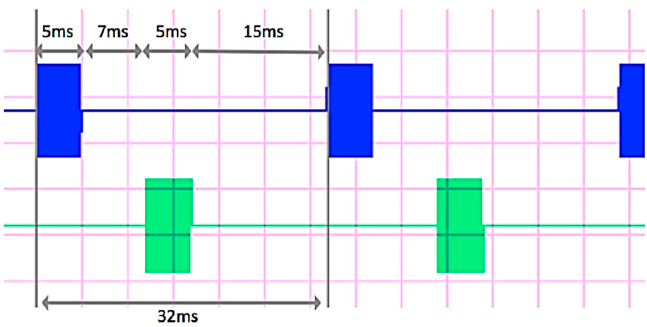
Figure 5. Current signals generated for the two wires.